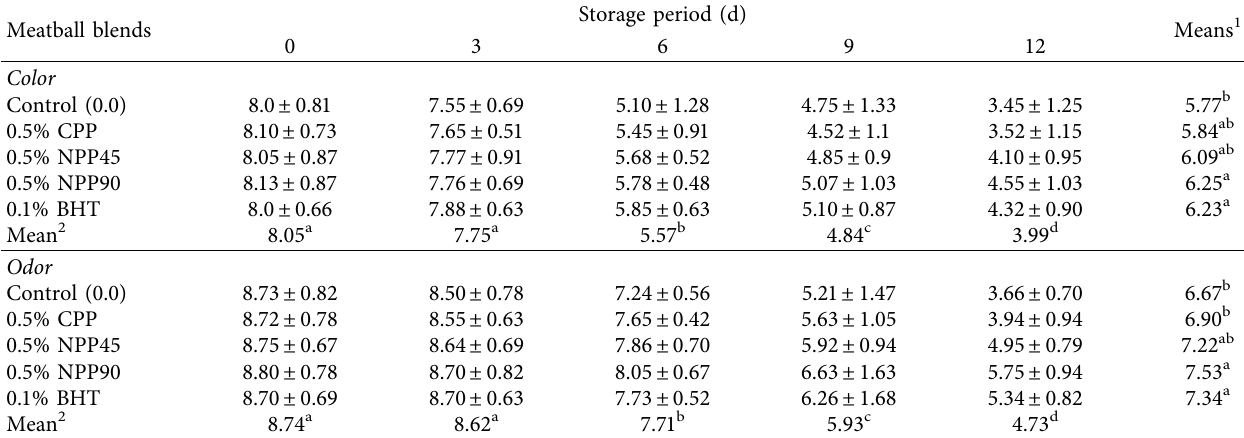
Table 5: Impact of nano-pomegranate peel on color and odor of cold stored meatballs. Meatball